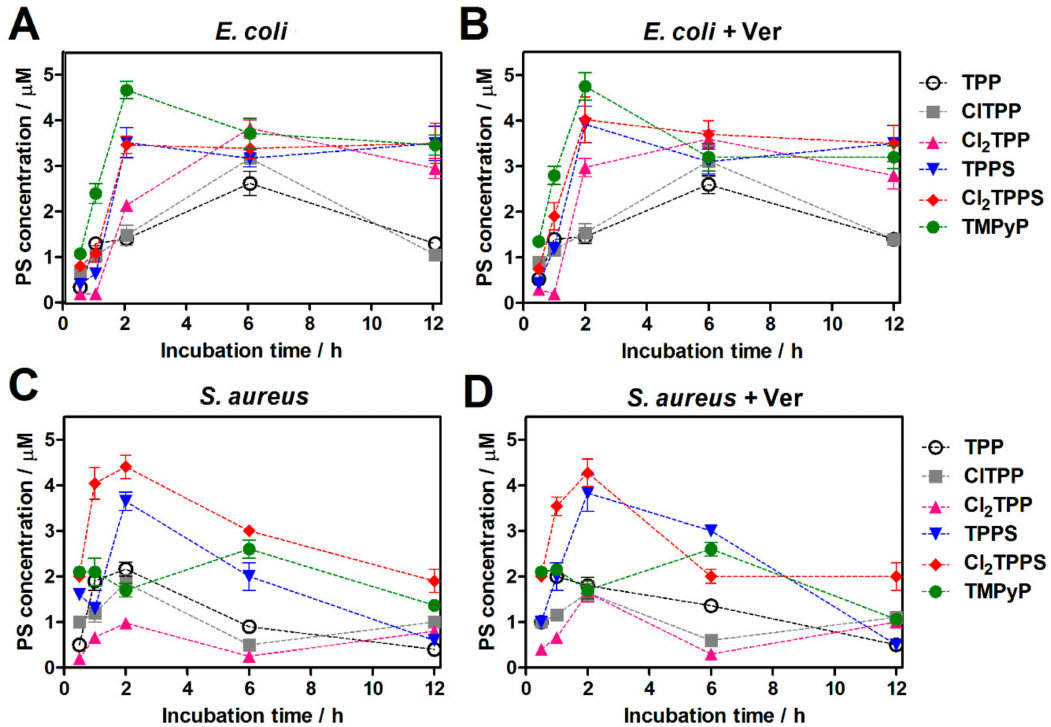
Figure 10. Time-dependent cellular uptake of PS with the initial 20 µ M concentration by E. coli without ( A ) and with verapamil ( B ) and S. aureus without ( C ) and with verapamil ( D ), for various incubation